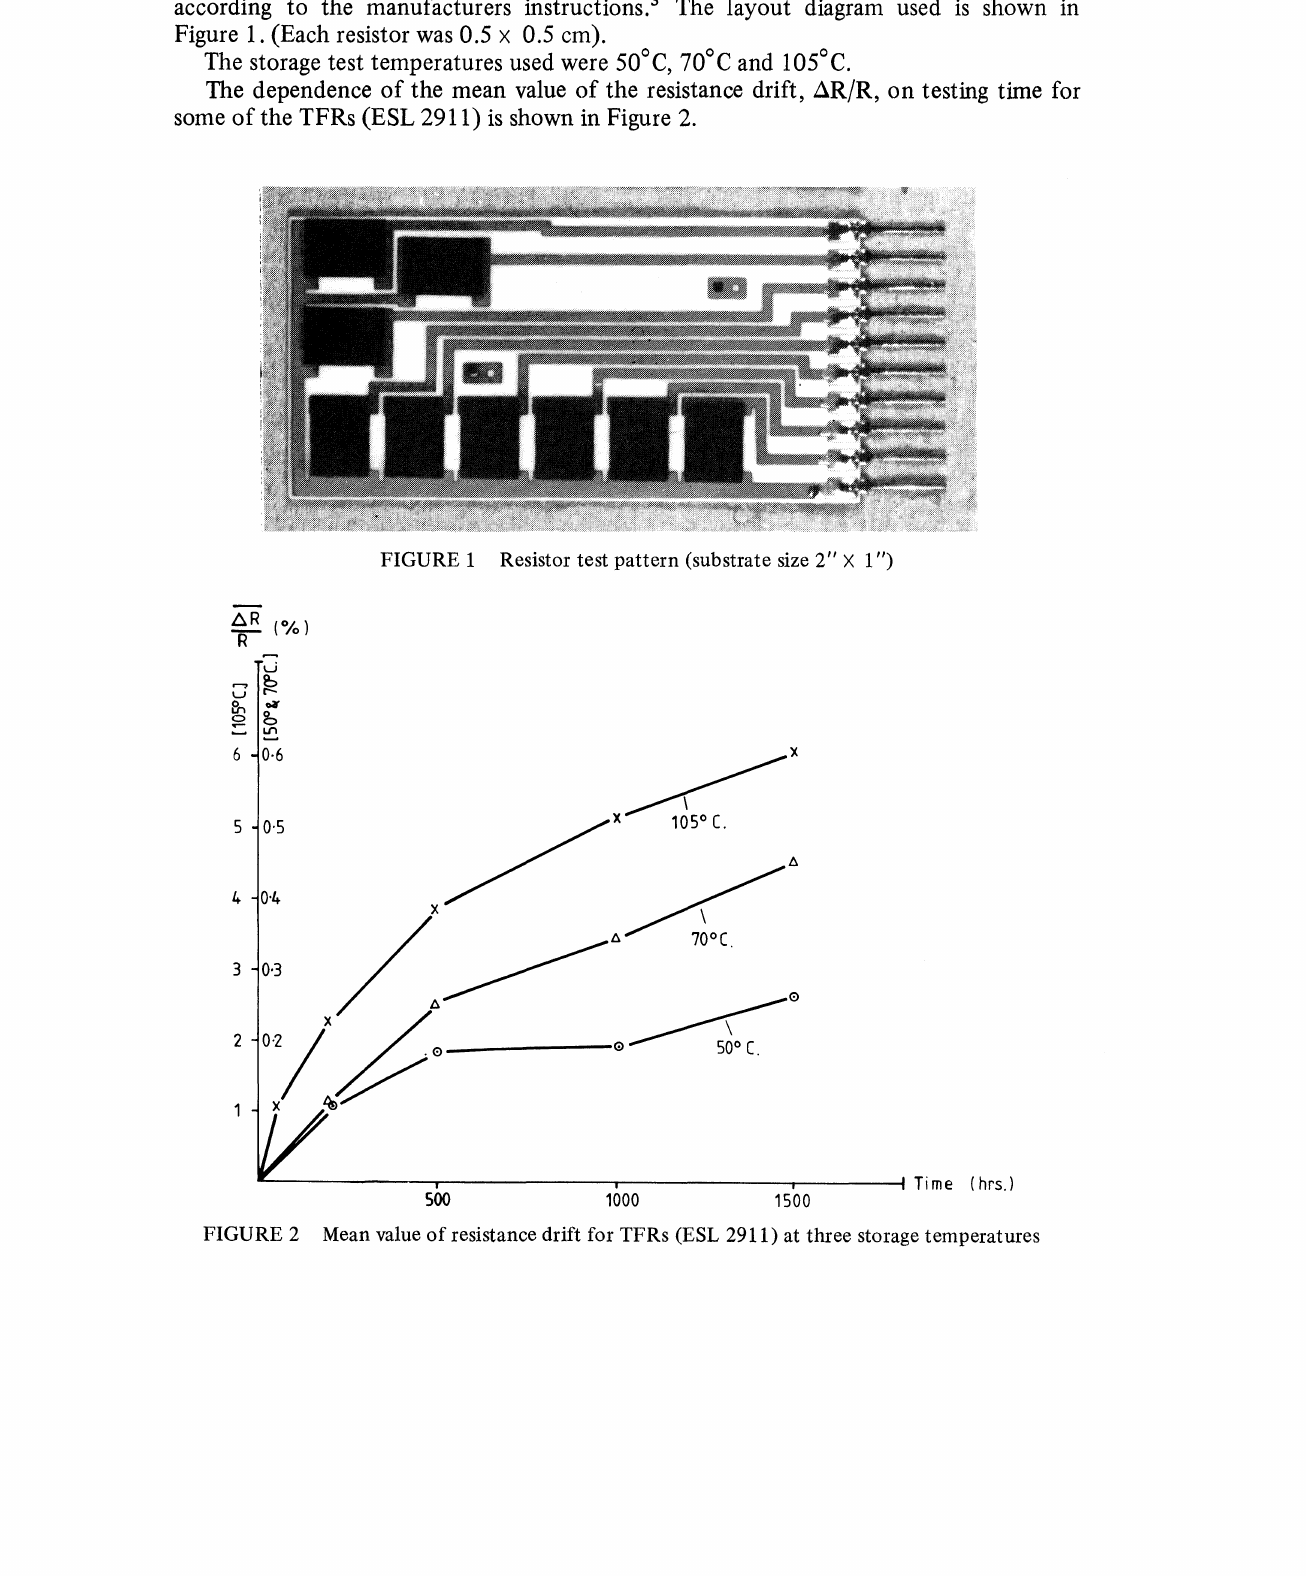
FIGURE 2 Mean value of resistance drift for TFRs (ESL 2911) at three storage